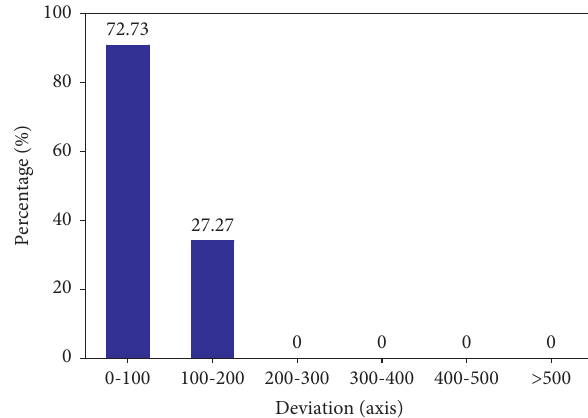
Figure 22: MAE histogram of right-turn trajectory prediction.